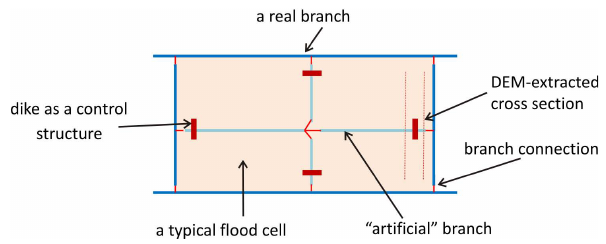
Fig. 4. Representation of a typical floodplain compartment in the Vietnamese part of the Delta.